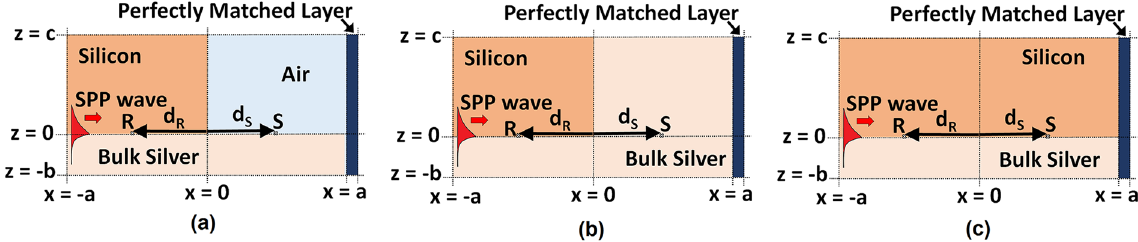
Figure 1. Schematic of the computational domain of the initial-boundary-value problem for information transfer by an amplitude-modulated SPP wave guided by a silver/silicon interface across a wall between silicon and another material. The signal is launched on the plane x a = − at time t 0 = and the wall between silver and either ( a ) air or ( b ) silver is identified as = −∞ < < ∞ > x y z { 0, , 0} . ( c ) Silicon continues beyond the plane = x 0 in the half space > z 0